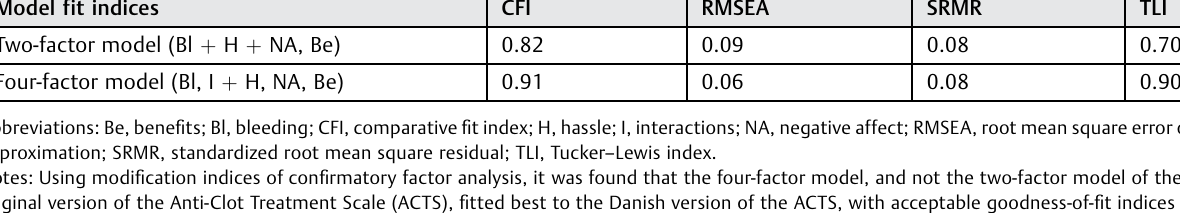
Table 3 Fit indices for the two- and four-factor models Model fit